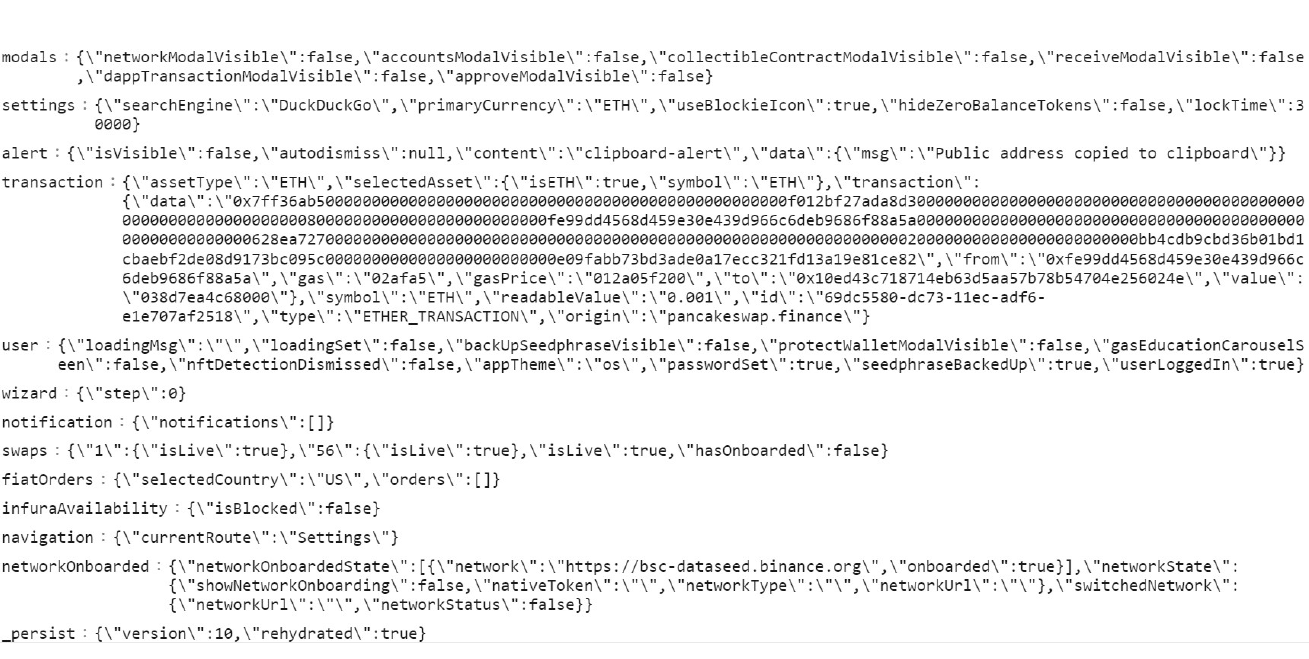
Figure 27. Content of settings, set alerts, another transaction activity, and user settings within the persist-root file.